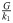
Testable predictions of the model.By approximating the huddle as a single super-organism, we are able to derive the following prediction from our theory of thermoregulatory huddling as the self-organising product of simple local interactions between pups. Accordingly the key parameter is the term Gk1, where G is the rate of thermogenesis and k
1 is the thermal conductance of each pup. The model predicts that either increasing thermogenesis (e.g., by pharmaceutically enhancing the action of brown adipose tissue) or decreasing the thermal conductance (e.g., by insulating each pup) will increase both the critical ambient temperature (single-headed arrow) and the range of ambient temperatures (double-headed arrow) over which the temperature of the huddle is stable. Confirming this prediction in future experiments would provide strong support for our description of the huddle as a self-organising system.